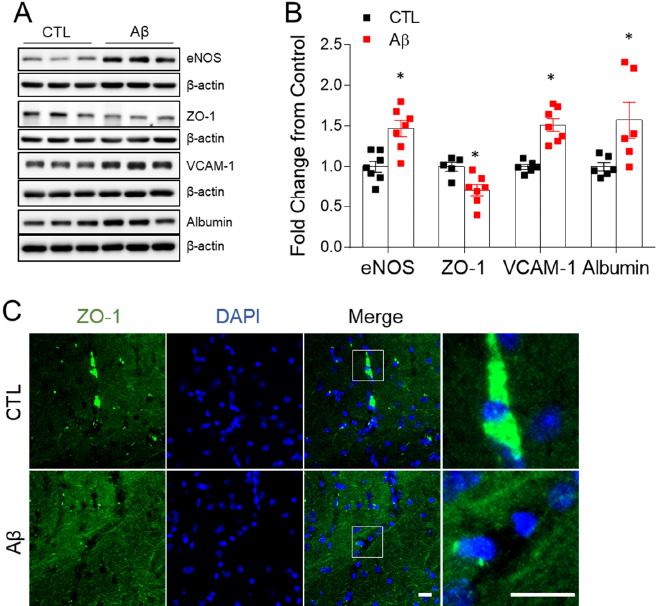
Figure 4. Effects of A β O toxicity on BBB leakage in the hippocampus. ( A ) Western blot analysis Figure 4. Effects of AβO toxicity on BBB leakage in the hippocampus. ( A ) Western blot analysis of eNOS, ZO-1, VCAM-1, and albumin in the hippocampus. ( B ) Quantitation of Western blot analysis of eNOS, ZO-1, VCAM-1, and albumin in the hippocampus. ( B ) Quantitation of Western blot in ( A ). To normalize total protein level, β-actin was used as a loading control. The data are presented analysis in ( A ). To normalize total protein level, β -actin was used as a loading control. The data are as mean ± SEM. * p < 0.05 for control compared with AβO-treated mice. ( C ) Representative immu- nofluorescence images (×200) of hippocampal CA1 regions showing ZO-1 (green). DAPI (blue) was presented as mean ± SEM. * p < 0.05 for control compared with A β O-treated mice. ( C ) Representative used to stain nuclei. Scale bar = 10 µm. immunofluorescence images ( × 200) of hippocampal CA1 regions showing ZO-1 (green). DAPI (blue) 3.5. Increased Expression of LCN2, MMP-9, and STAT-3 in the AD Mouse Model was used to stain nuclei. Scale bar = 10 µ m. Matrix-metalloproteinase 9 (MMP9) is known to increase BBB permeability and acti- vate neuroinflammation [26] and MMP9 was increased by intracerebral injection of Aβ in the mouse hippocampus [27]. In a previous study, we showed that MMP9 and LCN2 ex- pression increased simultaneously in hippocampal neurons of ob/ob mice, and that both were located in close proximity [11]. Thus, we first determined hippocampal LCN2 pro- tein. LCN2 expression was significantly in AβO-treated mice compared to controls (Figure 5A,B). MMP9 did also increase in the hippocampus of AD mice, as did phosphorylated signal transducer and activator of transcription 3 (STAT3) (Figure 5A,B). LCN2 expression was observed in GFAP-labeled astrocytes (Figure 5C). LCN2 from astrocytes is known to activate STAT3, and activated STAT3 promotes the production of pro-inflammatory cyto- kines, including MMP9, TNF-α, and IL-6 [28,29].